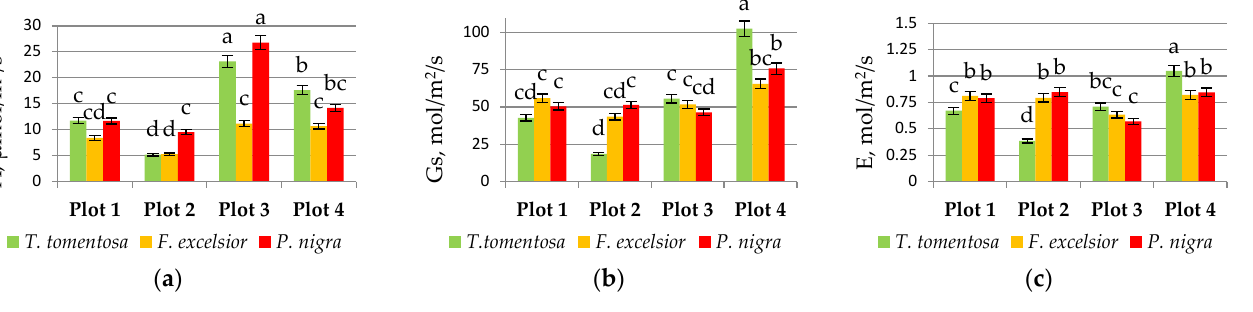
Figure 4. Physiological plant traits: ( a ) intensity of photosynthesis (A, µmol m − 2 s − 1 ), ( b ) stomatal conductance (Gs,µmol m − 2 s − 1 ), and ( c ) intensity of transpiration (E, µmol m − 2 s − 1 ) in August 2020— six years after transplantation into the urban environment. Values with di ff erent le tt ers indicate sig- ni fi cant di ff erences ( p < 0.05).